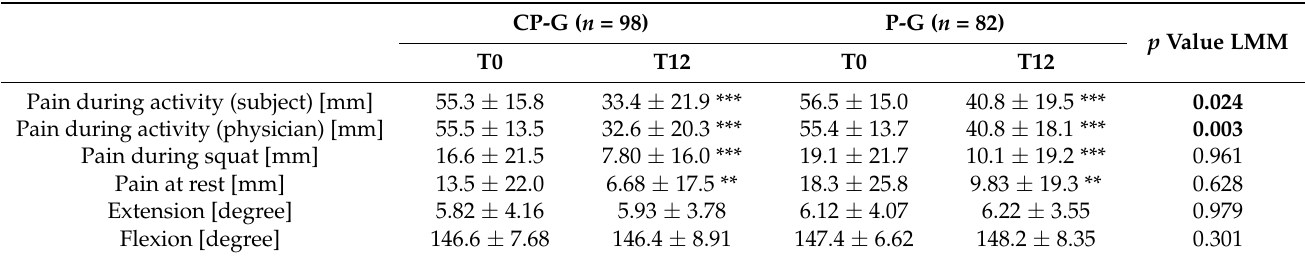
Table 2. Knee pain and range of motion in the PP